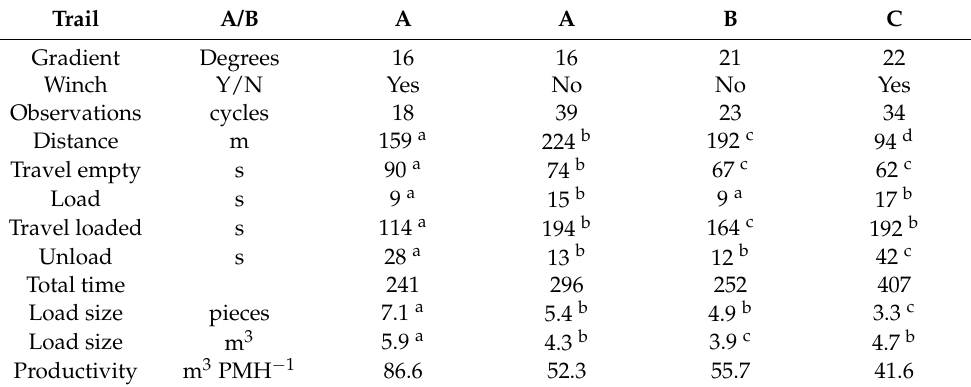
Table 2. Mean values for the main skidder performance indicators (time consumption, load size, productivity). Trail A/B Gradient Degrees Winch No Yes Observations cycles